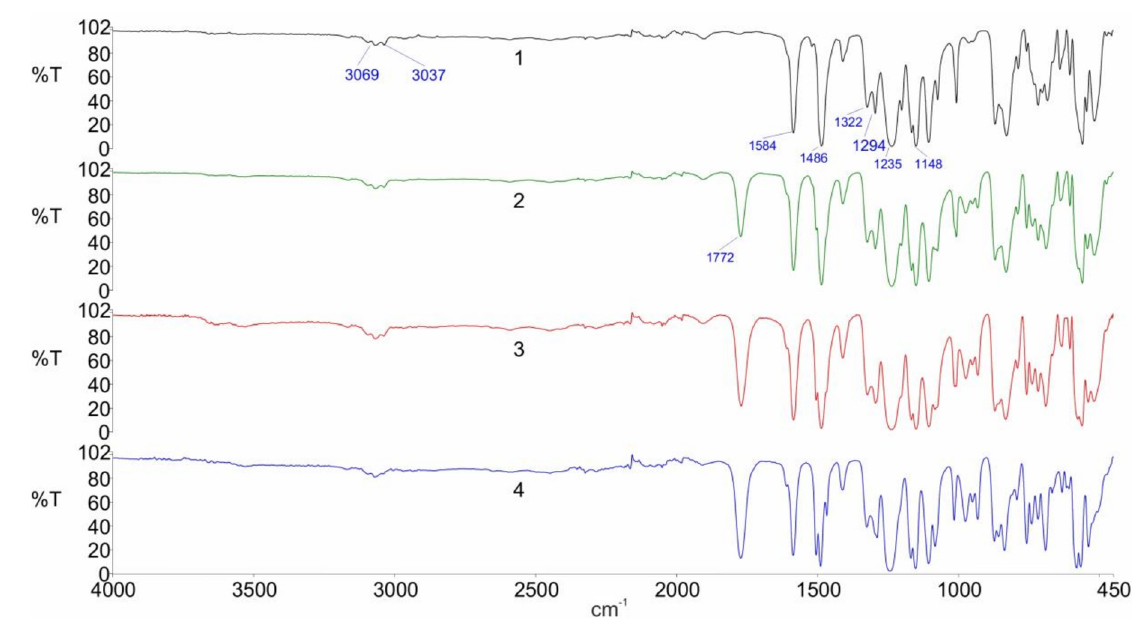
Figure 1. IR spectra: 1—PPSU; 2—PPSU-C-30; 3—PPSU-C-50;